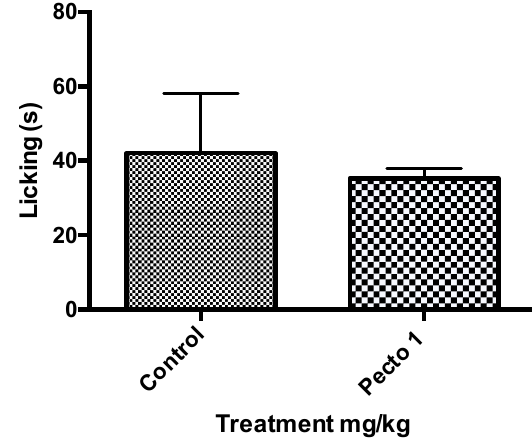
Figure 5. The pilot results of 1 (P) (1 mg/kg of pectolinarigenin) using students t-test to analyse the data. Treatment with Pectolinarigenin was not statistically significant.